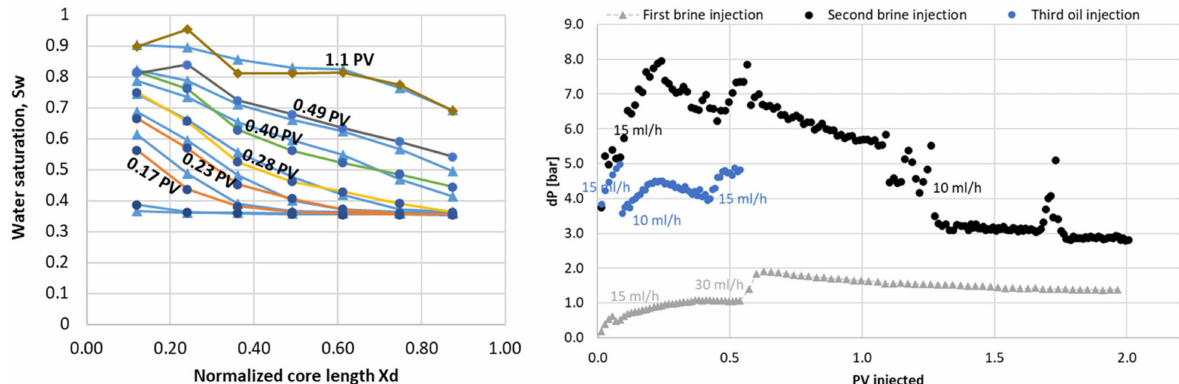
Figure 16. Water displacement after polymer was visualized by PET imaging. Saturation development may be seen in the left figure, while the differential pressure development is given on the